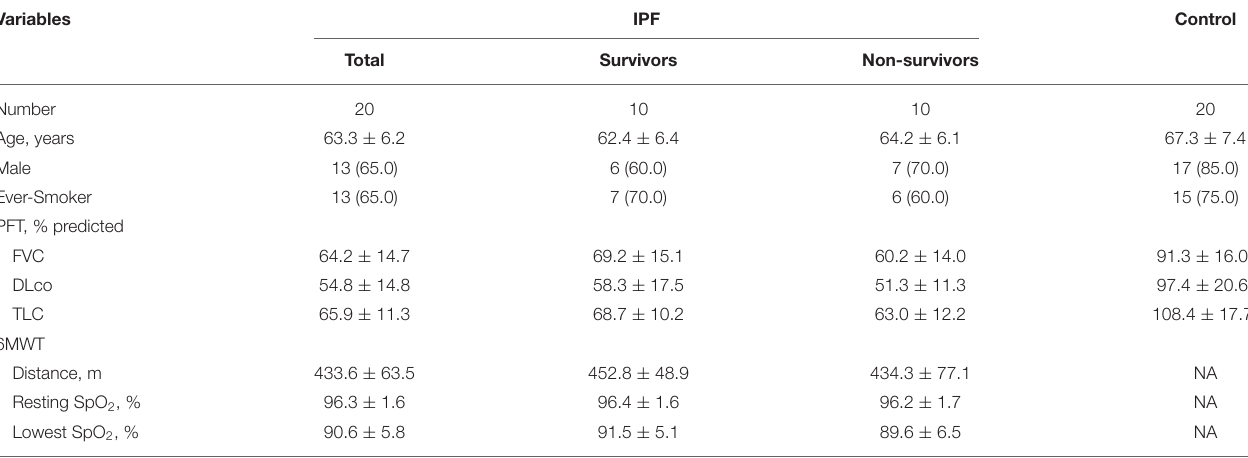
TABLE 1 | Comparison of baseline characteristics between IPF and control